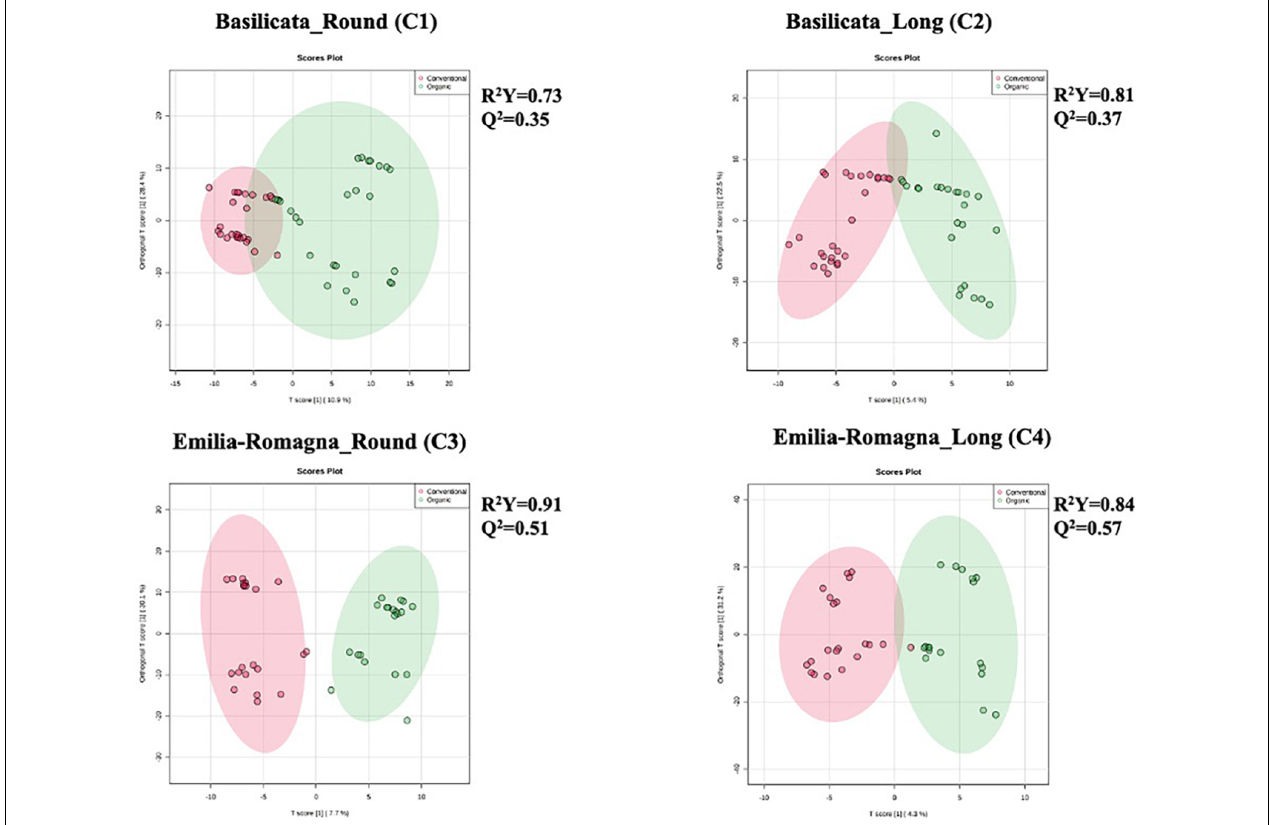
FIGURE 2 | Different orthogonal projections to latent structures discriminant analysis (OPLS-DA) models relative to untargeted phytochemical profile of tomato samples, built considering the following comparisons: C1 (Basilicata; Cultivar: Round; Organic vs. Conventional), C2 (Basilicata; Cultivar: Long; Organic